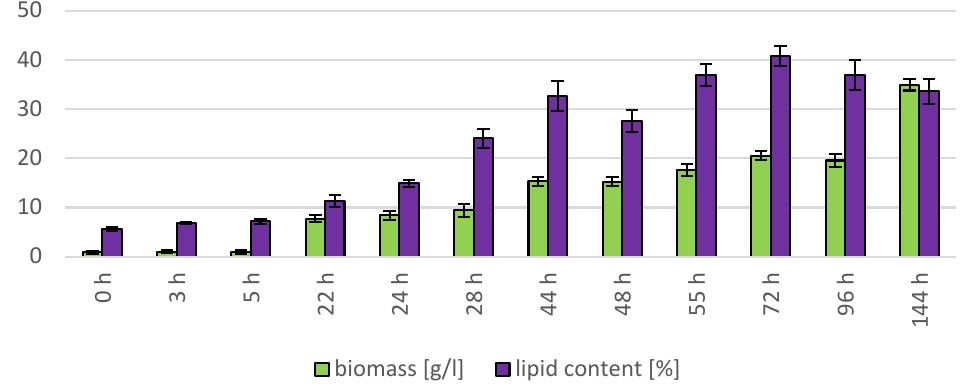
Figure 8. Lipid and biomass content in yeast strain R. toruloides in conditions of C/N ratio 25 culti- vated in bioreactor.